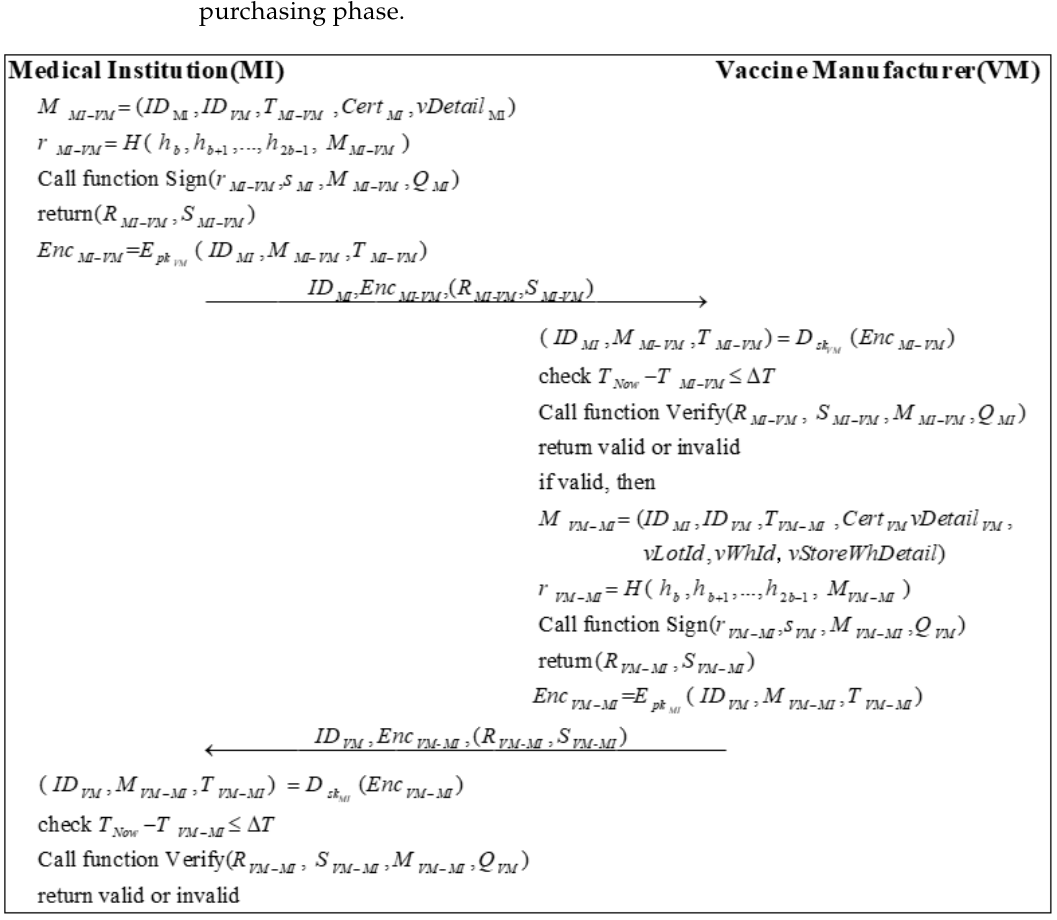
Figure 6. The process of vaccine purchase.